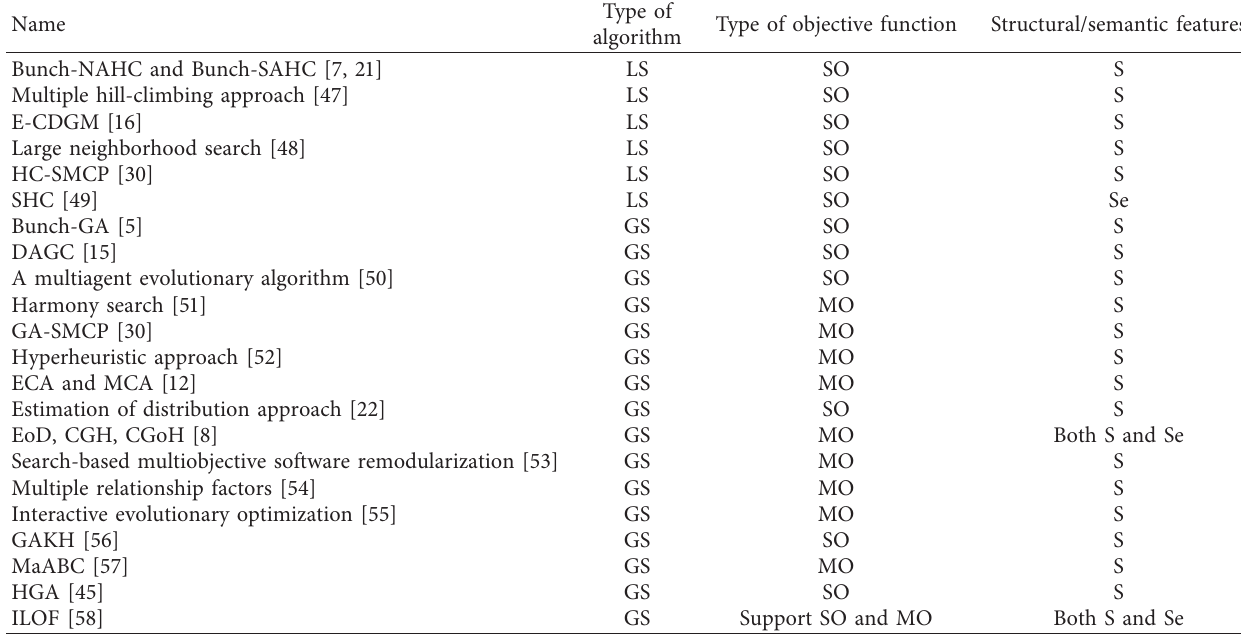
Table 1: Some search-based software clustering